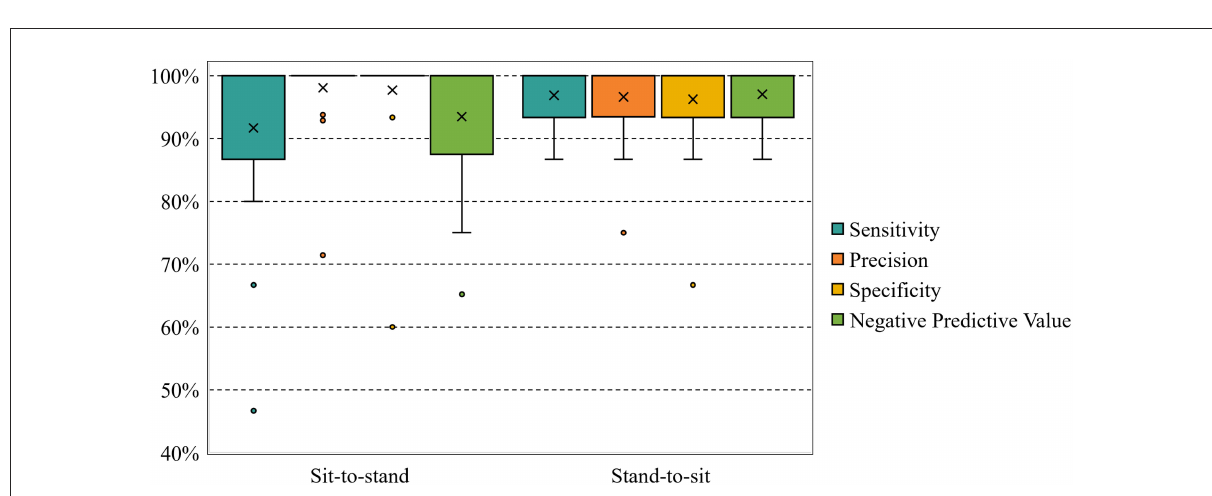
FIGURE8 Across-all-participants distributions (%) of sensitivity, precision, specificity, and negative predictive value obtained in the sit-to-stand and stand-to-sit online experiments. × represents the mean. The Supplementary material section provides the result for each